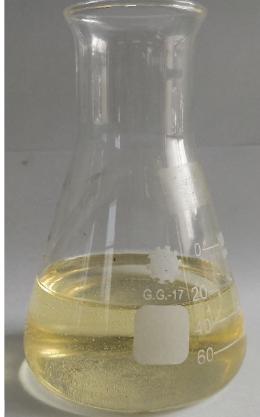
Figure 1: The environment-friendly organic polymer.